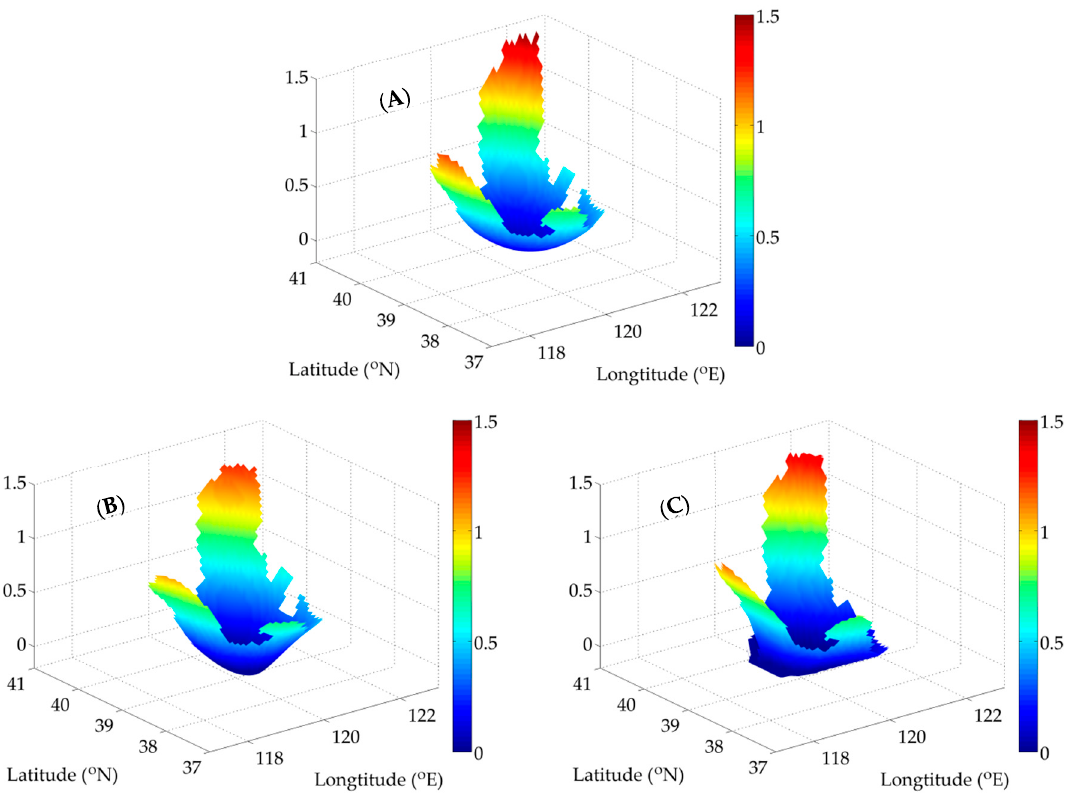
Figure 8. Comparison of the interpolation results by the SI and CI. ( A ) The prescribed surface; ( B ) the interpolation result by the SI; ( C ) the interpolation result by the CI (unit: mmol N m -3 ).